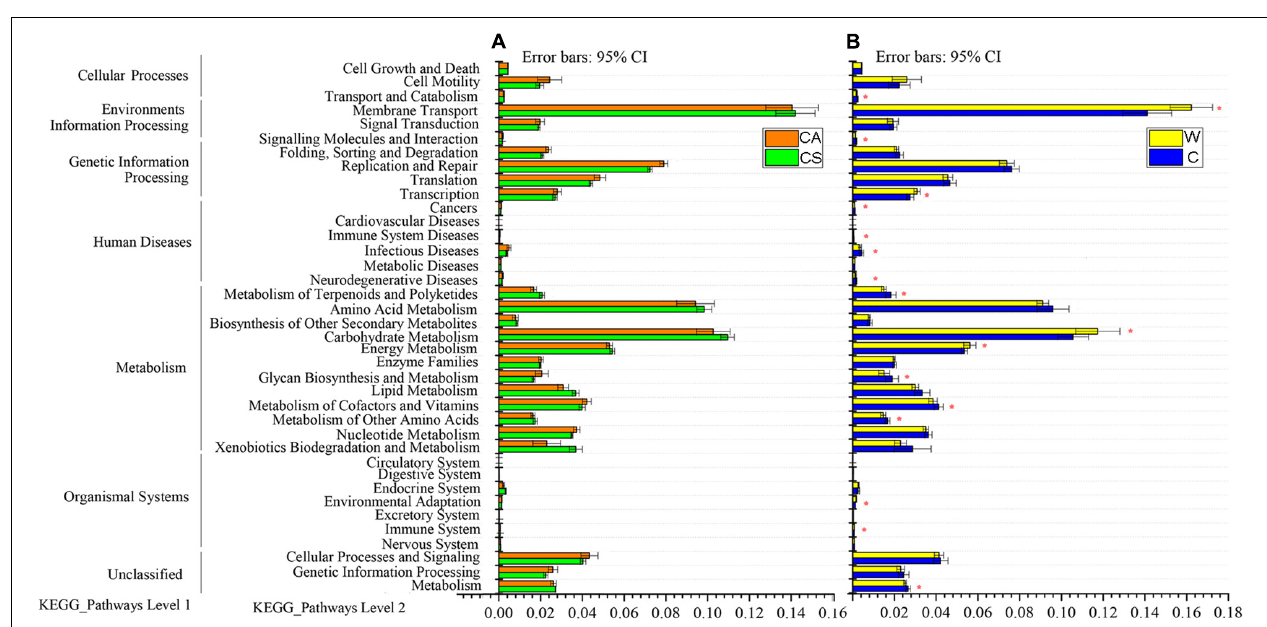
FIGURE 3 | Relative abundances of predicted genes in the metagenome related to level-1 and level-2 KEGG pathways; (A) red boxes, CS (summer) group; green boxes, CA (autumn) group; (B) yellow boxes, W (wild frogs) group; blue boxes, C (captive frogs) group. Asterisks indicate significant differences between groups.